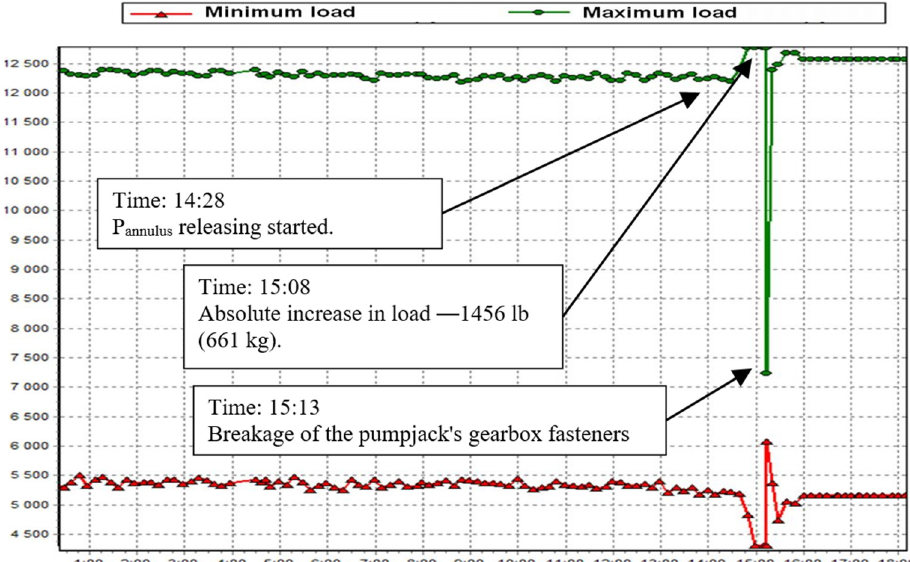
Figure 3. Day 2 graph of load variations on the polished rod after extraction of gas at the well No.14764d.